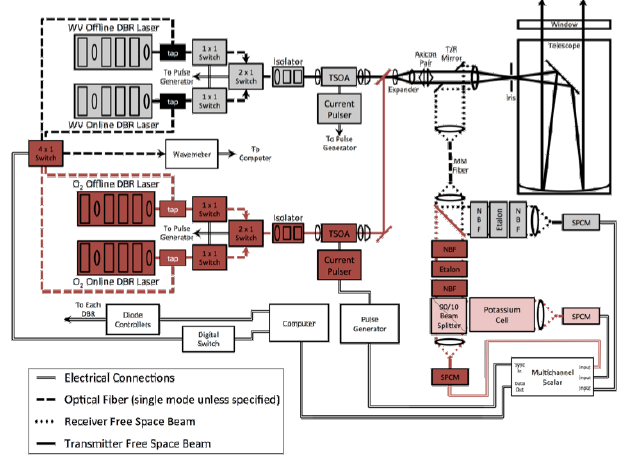
Figure 1: Block diagram of a combined DIAL/HSRL system capable of measuring atmospheric thermodynamic